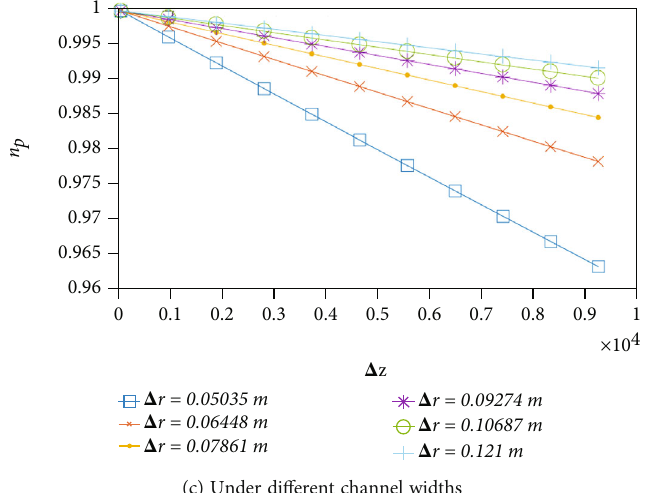
Figure 5: Variation of primary electron density under di ff erent parameters.